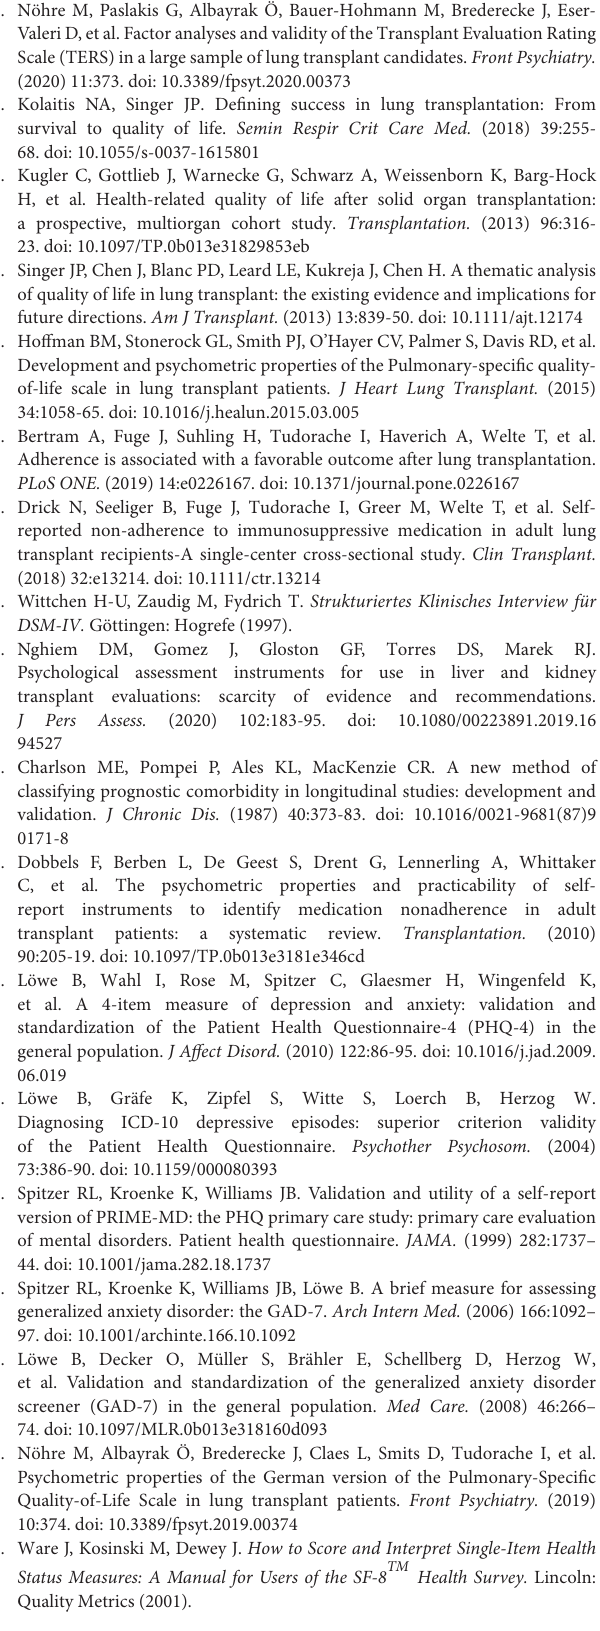
Status Measures: A Manual for Users of the SF-8 TM Health Survey. Lincoln: Quality Metrics (2001).